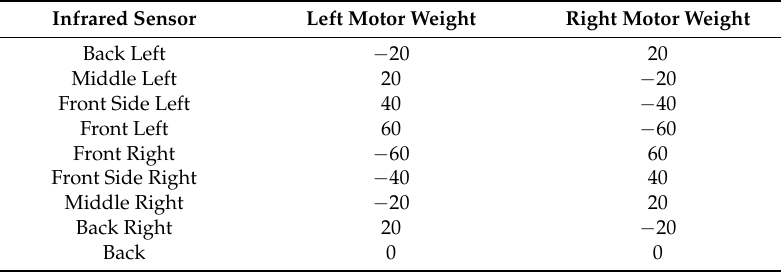
Table 2. The infrared sensor weights used in the